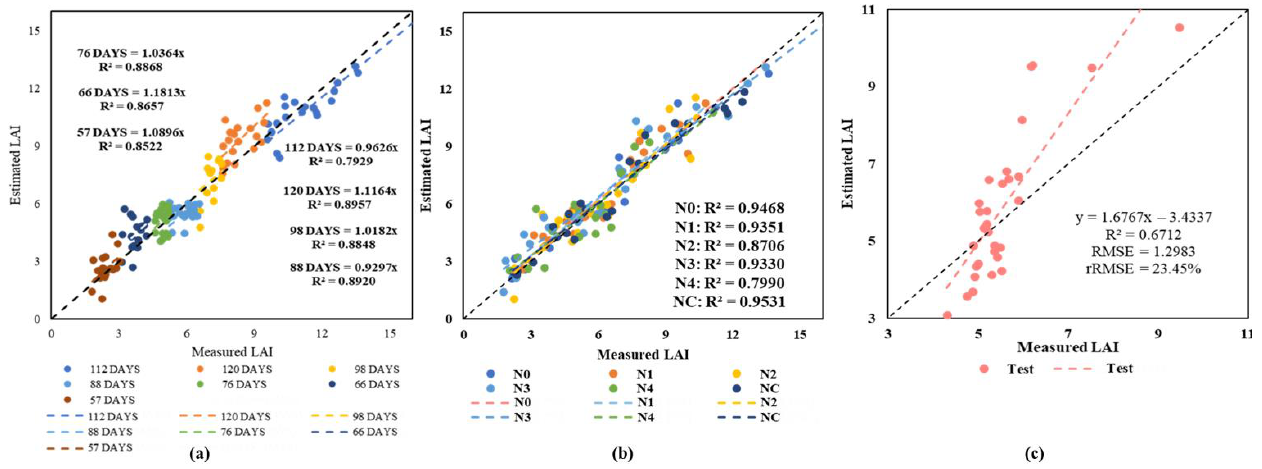
Table 10. Cotton LAI monitoring verification results of different N concentrations in the optimal model.